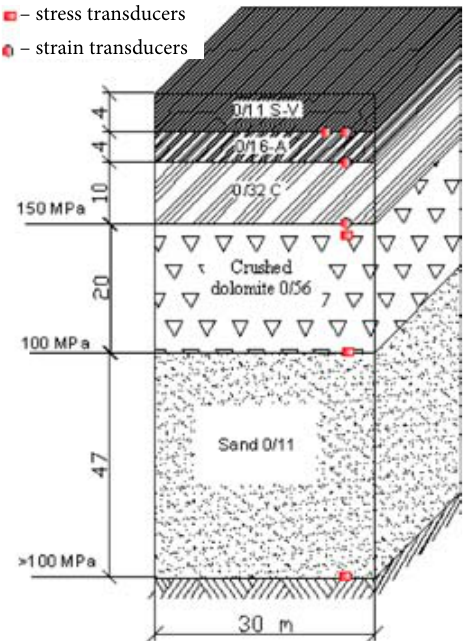
fig. 1. The base structure of experimental pavements and positions of